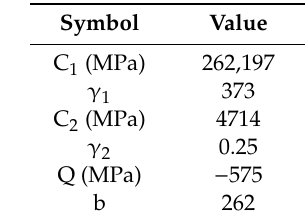
Table 1. Identified material parameters for 50CrMo4 (38 HRC) after fitting of force–displacement at 50 N.